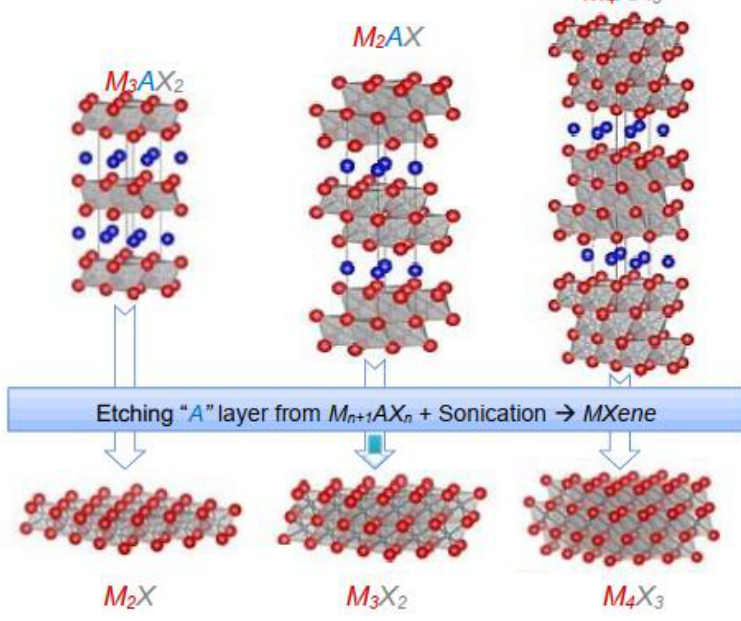
Figure 1. Schematic figure with crystal structure showing the conversion of MAX ( top ) to MXene ( bottom ). Reprinted with permission from Reference